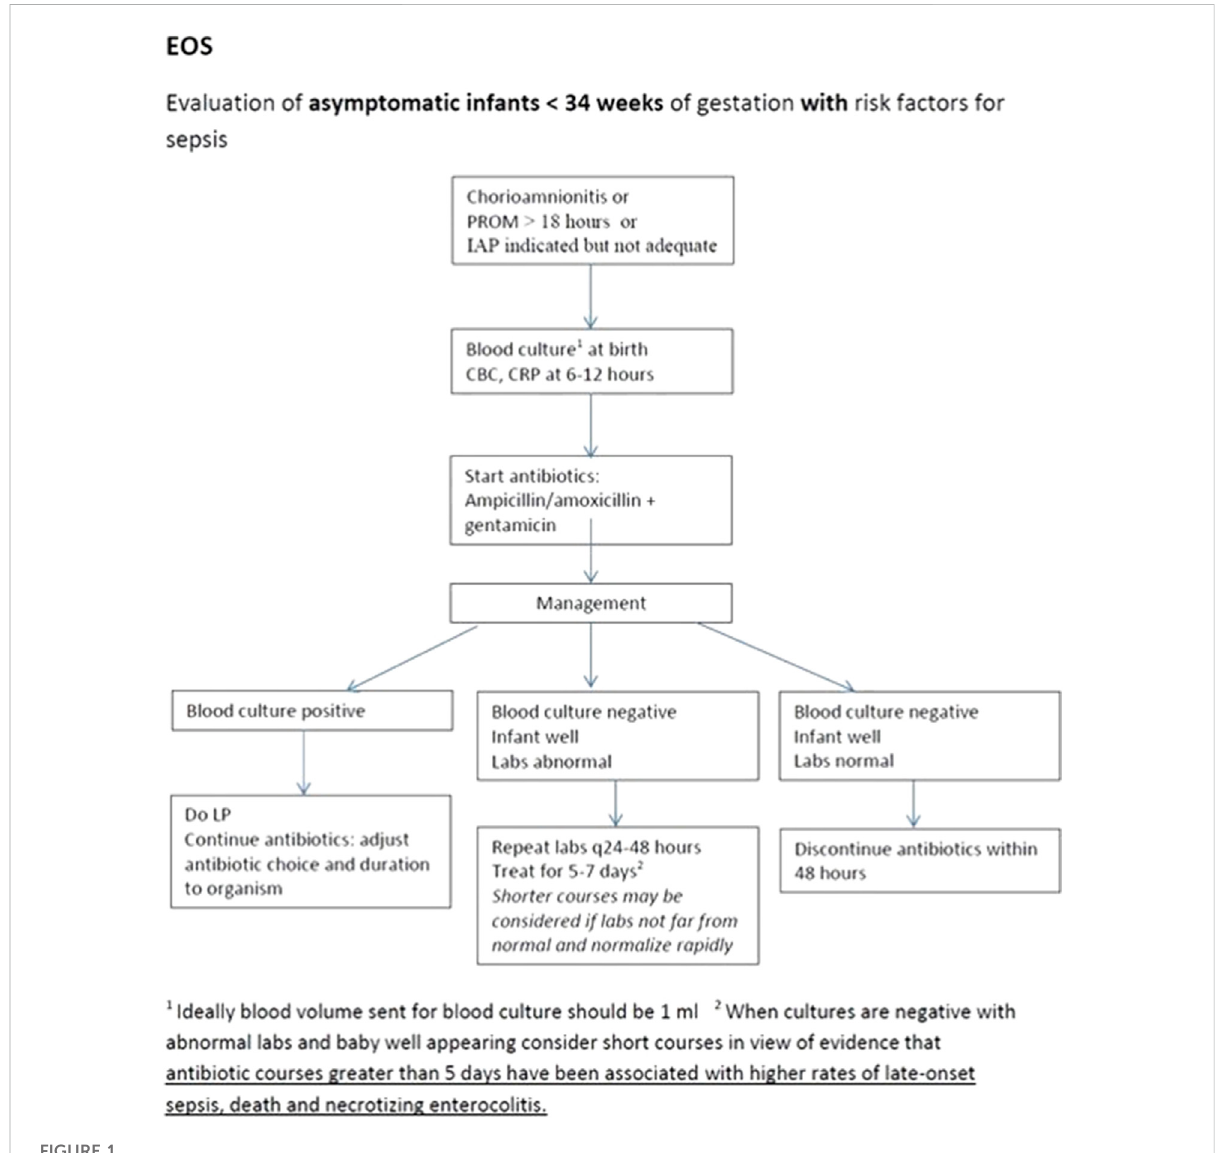
FIGURE 1 An example of the algorithm used to guide the work up of neonates with suspected